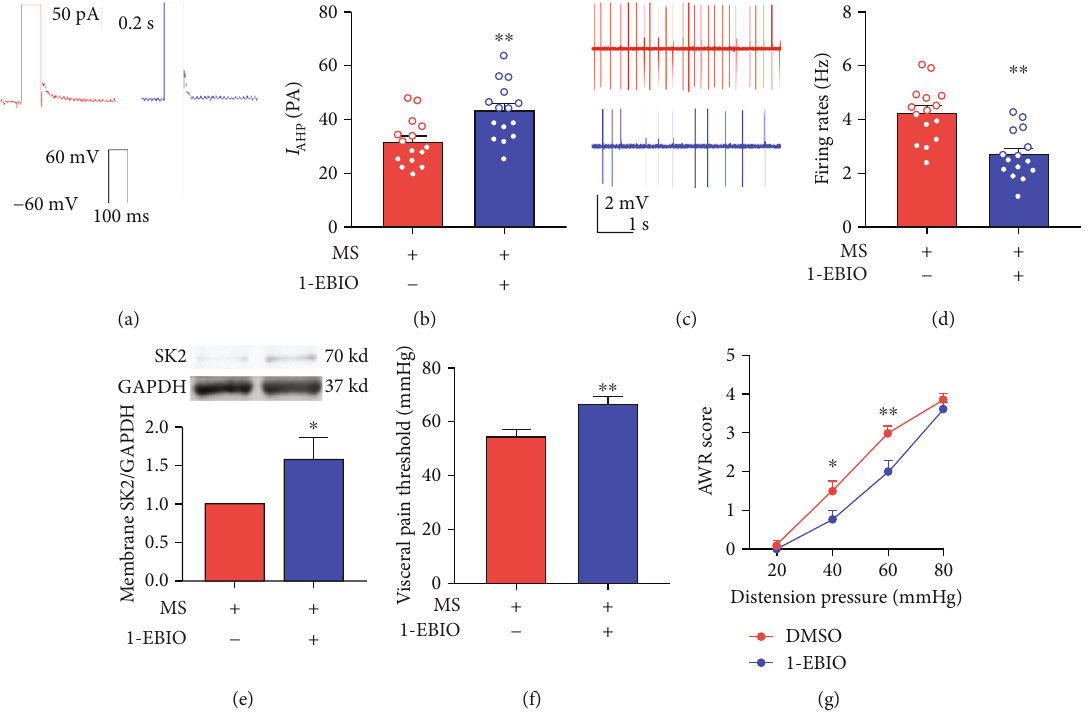
fi ring rates, SK2 protein in membrane fraction, and visceral pain Figure 6: E ff ects of SK2 activator 1-EBIO on I AHP , spontaneous neuronal threshold. (a, b) 1-EBIO administration increased the amplitude of I AHP in mice with neonatal MS ( t -test, t = 3 : 30 , P < 0 : 01 , n = 15 neurons/5 mice per group). (c, d) 1-EBIO administration decreased the neuronal fi ring rates in the spinal DH of mice with neonatal MS ( t -test, t = 4 : 38 , P < 0 : 01 , n = 15 neurons/5 mice per group). (e) 1-EBIO administration caused the increase of the spinal SK2 channel in membrane fraction in MS mice ( t -test, t = 2 : 43 , P < 0 : 05 , n = 6 per group). (f) 1-EBIO administration e ff ectively reversed the decrease of visceral pain threshold due to neonatal MS ( t -test, t = 3 : 02 , P < 0 : 01 , n = 8 per group). (g) MS mice with intrathecal injection of 1-EBIO exhibited decreased AWR scores in response to the distension pressures at 40mmHg (Bonferroni post hoc test, P < 0 : 05 ) and 60mmHg (Bonferroni post hoc test, P < 0 : 01 ) (two-way ANOVA test, F ð 1, 14 Þ = 5 : 76 , P < 0 : 05 , n = 8 per group). Data are expressed as mean ± SEM ; ∗ P < 0 : 05 and ∗∗ P < 0 : 01